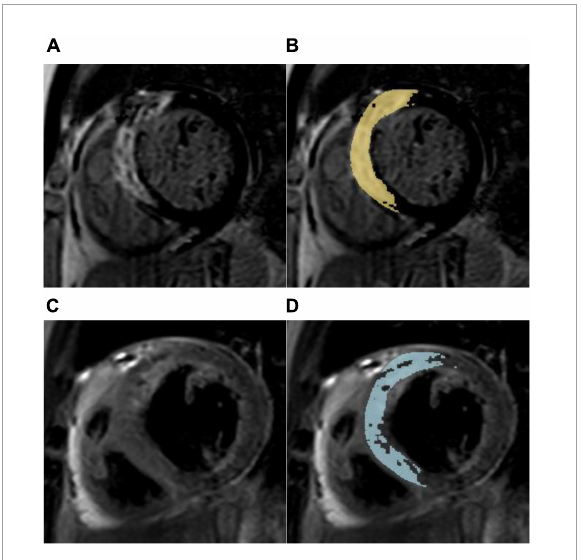
FIGURE2 Myocardial salvage assessment in a 67-year-old male with a myocardial salvage index < median after acute reperfused myocardial infarction. (A) Representative short-axis late gadolinium enhancement (LGE) image showing a high signal intensity of the anterior, anteroseptal, and inferoseptal segments indicating myocardial necrosis. (B) Computer-aided signal intensity analysis of LGE image normalized to remote uninjured myocardium. The myocardial infarct size was 20.95%LV (left ventricle). (C) T2-weighted spectral attenuated inversion recovery image showing myocardial edema (area at risk) in the same region. (D) Computer-aided signal intensity analysis of the T2-weighted image normalized to remote normal myocardium. The myocardial area at risk was 34.30% LV, and the myocardial salvage index was 39.1. This patient with anterior myocardial infarction suffered non-fatal myocardial reinfarction and congestive heart failure during a 3-year follow-up.